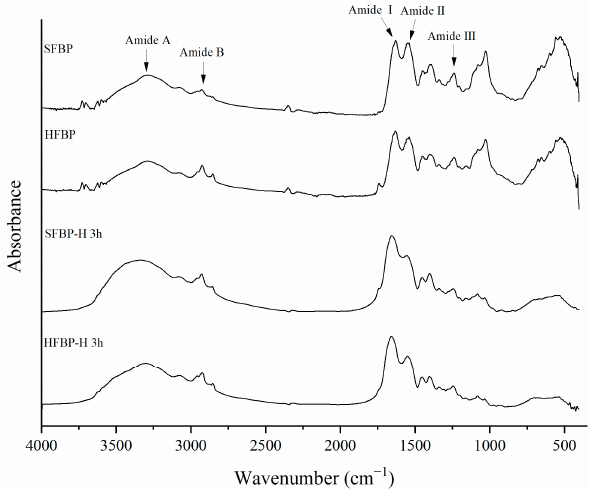
Figure 2. FTIR spectra of SFBP, HFBP, SFBP-H and HFBP-H. SFBP: fish bone protein prepared through steam explosion-assisted extraction; HFBP: fish bone protein prepared through hot-pressure extraction; SFBP-H: SFBP hydrolysates; HFBP-H: HFBP hydrolysates.